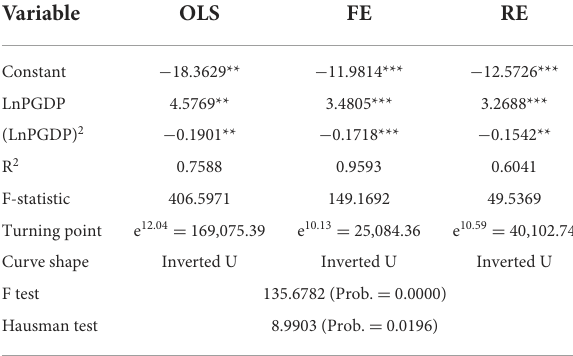
TABLE 4 Model estimation